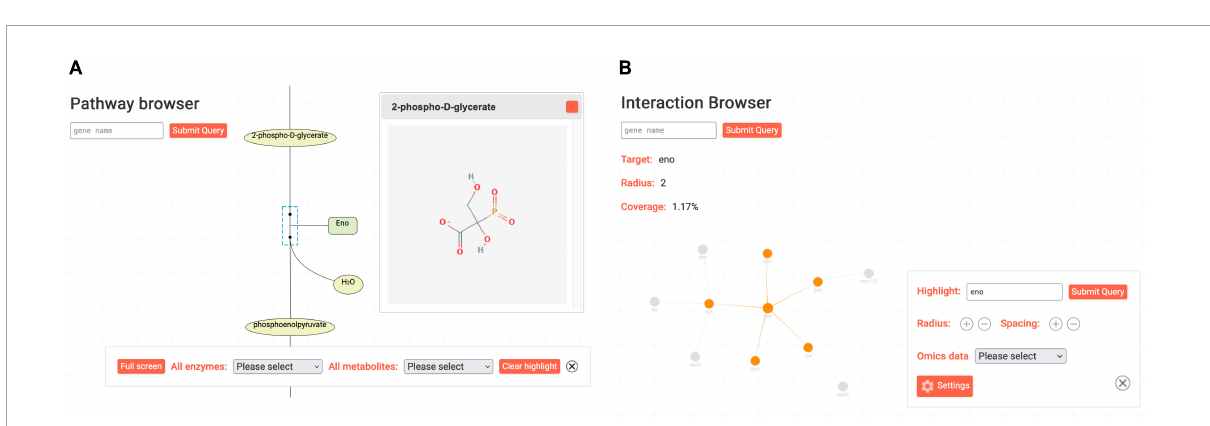
FIGURE4 Interaction and Pathway Browser with Eno highlighted. (A) The Pathway Browser features a curated map of metabolic reactions. Selected enzymes and metabolites can be highlighted using the toolbar. (B) The Interaction Browser allows viewing interaction networks of genes. With the toolbar, the size and appearance of the currently viewed network can be